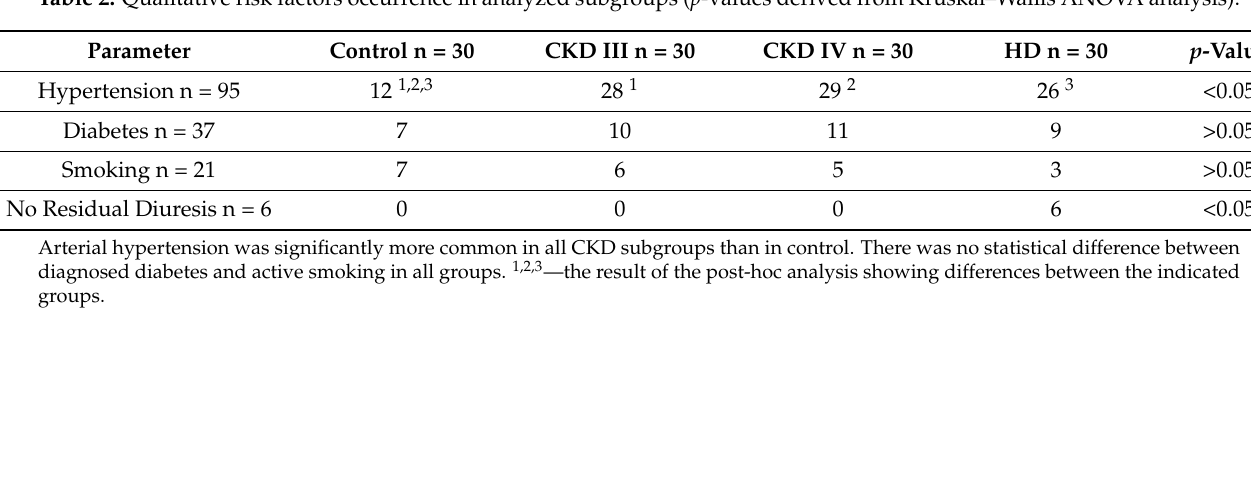
Table 2. Qualitative risk factors occurrence in analyzed subgroups ( p -values derived from Kruskal–Wallis ANOVA